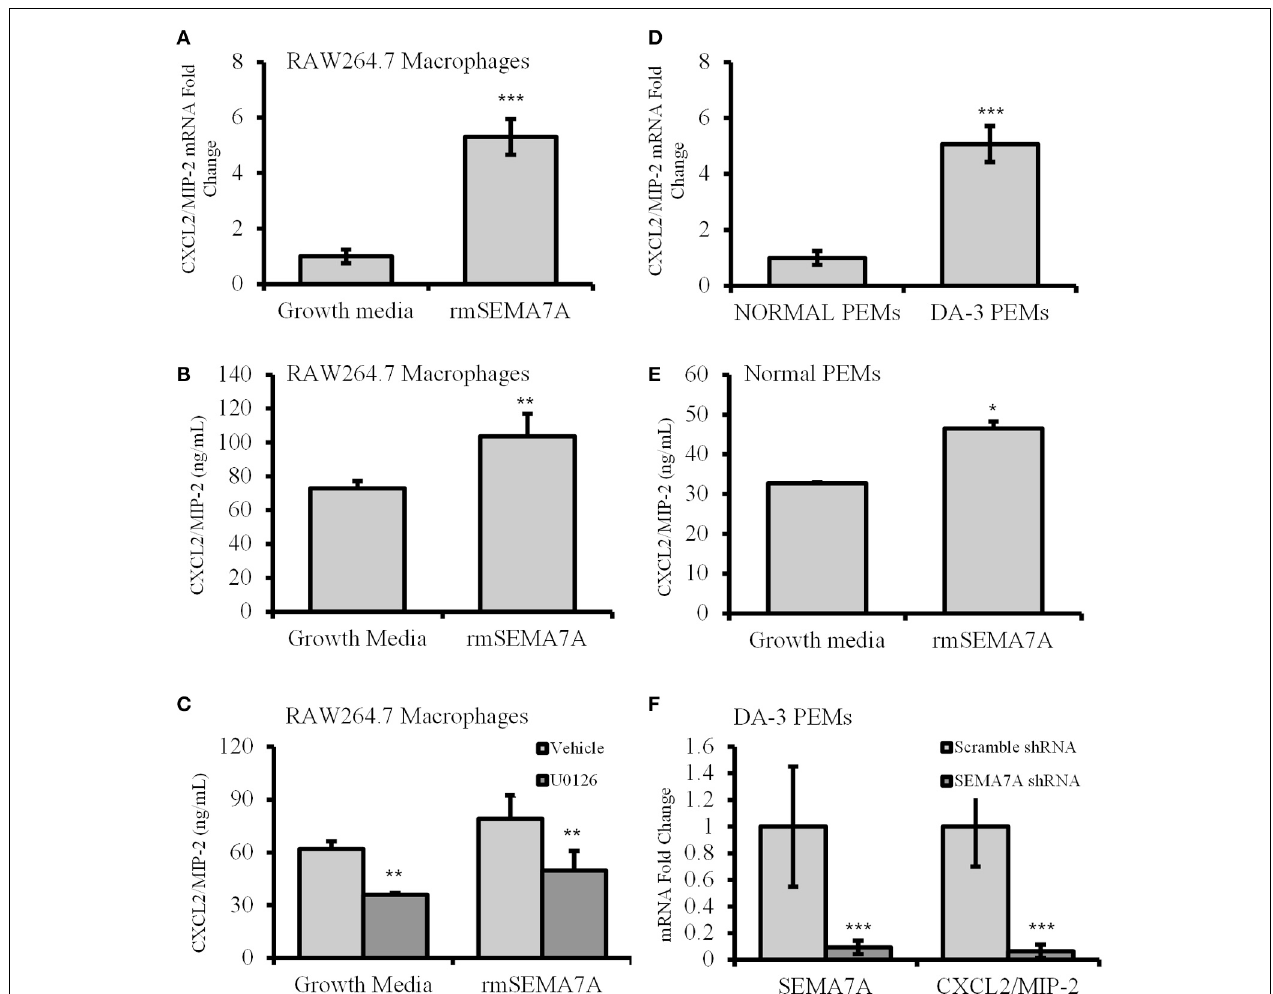
FIGURE 3 | Increased expression of angiogenic chemokine, CXCL2/MIP-2 in rmSEMA7A treated RAW264.7 macrophages and peritoneal elicited macrophages from mammary tumor-bearing mice. The effect of treatment with rmSEMA7A in RAW264.7 macrophages is shown in panels (A–C) . Expression of CXCL2/MIP-2 at mRNA level (A) and at protein level determined by ELISA (B) is increased in RAW 264.7 macrophages treated with rmSEMA7A; and (C) effect of treatment with U0126, a MAPK inhibitor (1 μ M) on CXCL2/MIP-2 expression by RAW 264.7 macrophages treated with rmSEMA7A. CXCL2/MIP-2 expression is